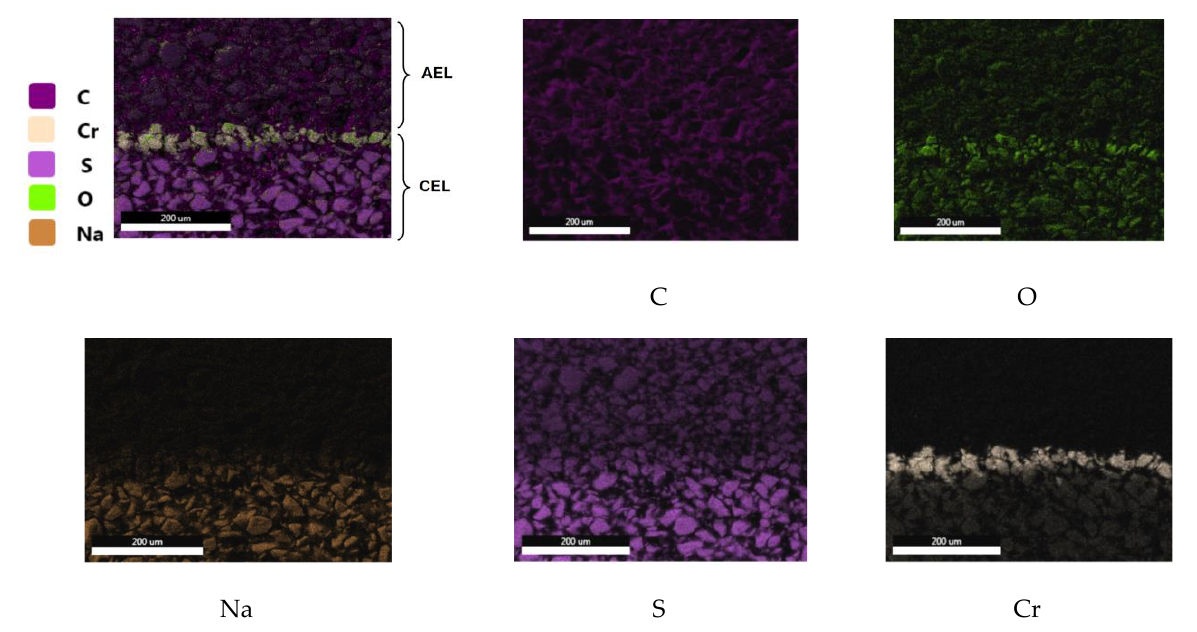
Figure 5. Elemental analysis of a cross section of a bipolar MB-2-Cr membrane, AEL, anion-exchange layer, CAL, cation-exchange layer.